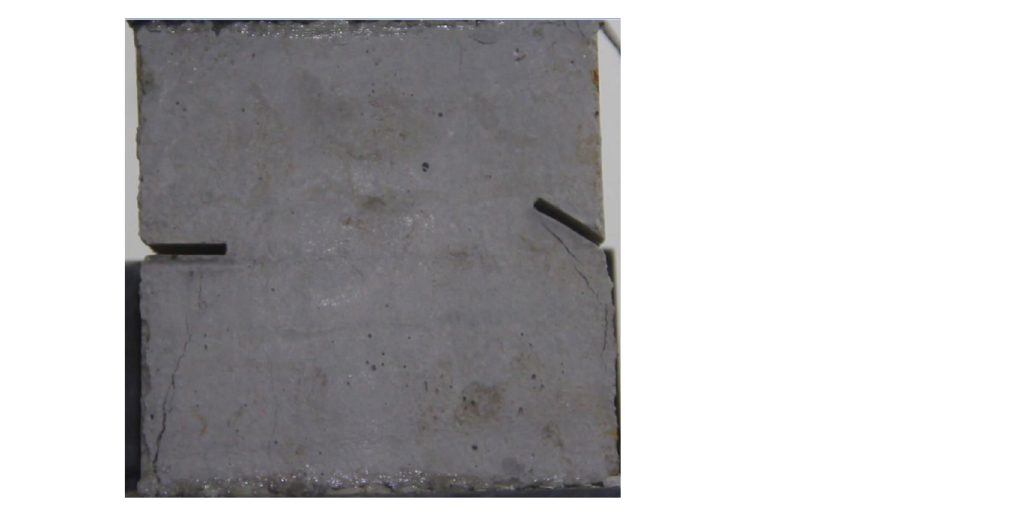
Figure 15. Photograph of a specimen showing tensile crack from the bottom surface caused by compression and anti-tensile wing crack